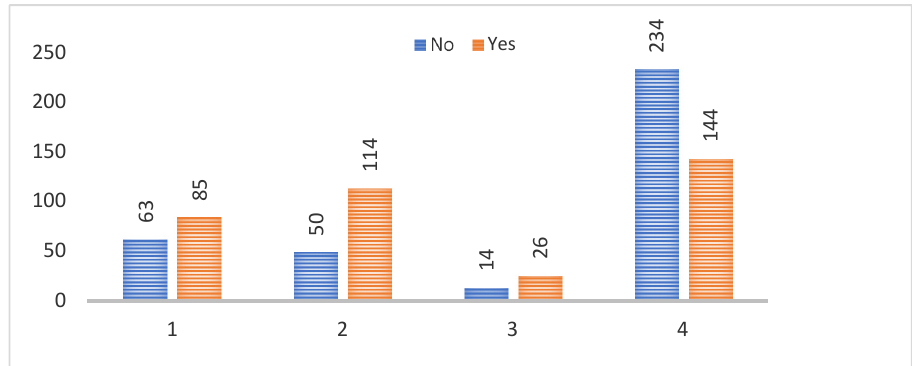
Figure 2. Distribution of respondents by answers to the question, “Did you work before study?” (no, yes) and “Are you currently working in addition to studying?” (1, yes, I have a permanent job; 2, yes, I work part-time/I have an internship; 3, yes, I have my own business; 4, no, I do not work). Source: Compiled by the authors based on their research.